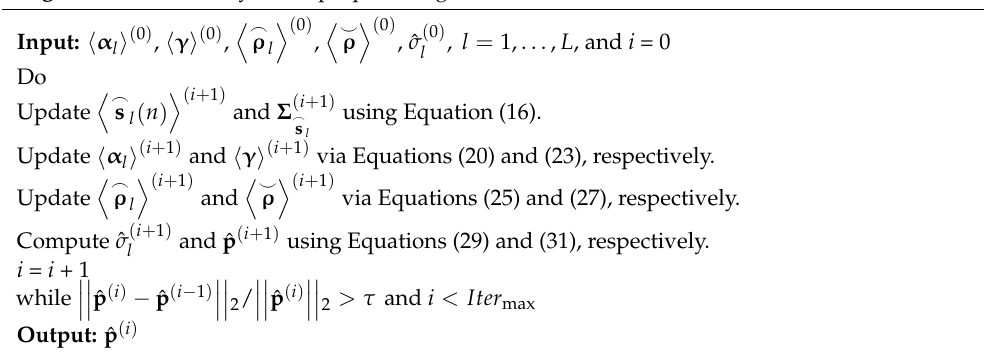
Algorithm 1. Summary of the proposed